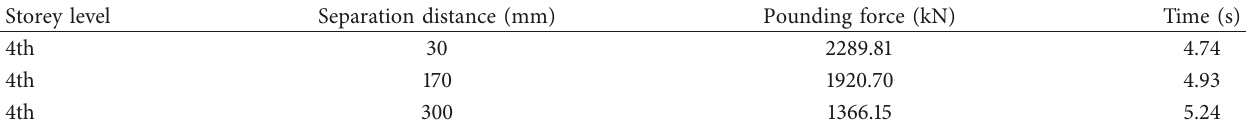
Table 8: Effect of different seismic gaps on the pounding force at the pounding level.